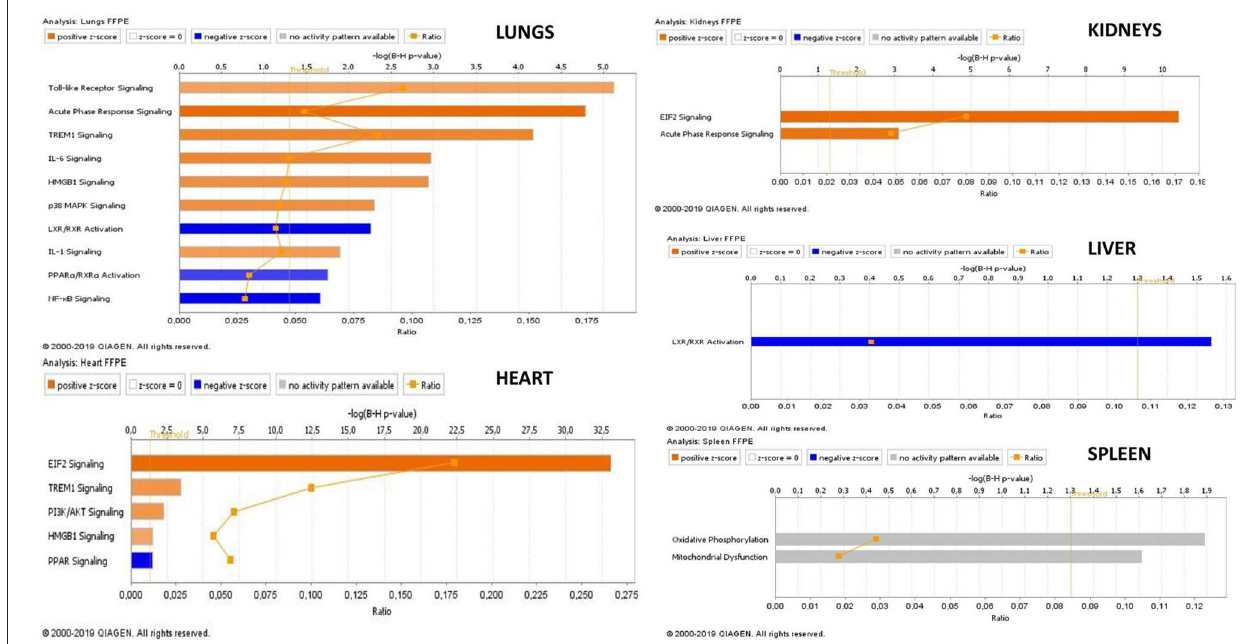
FIGURE 6 | Transcriptional profiles of canonical pathways in FFPE tissue samples from meningococcal septic shock patients. The figure displays the top canonical pathways enriched in each organ. The mean values of N. meningitidis DNA/ µ g human DNA was in lungs: 2.5 × 10 8 , heart 5.4 × 10 7 , kidneys 4.6 × 10 6 liver 8.3 × 10 7 , and spleen 9.4 × 10 4 . A ≪ core analysis ≫ was performed separately for each organ. Significantly enriched canonical pathways were identified with a right-tailed Fisher’s Exact Test ( p < 0.05, after correction for multiple testing using the Benjamini-Hochberg method). Ratio denotes the number of significantly expressed genes compared with the total number of genes associated with the canonical pathway. The Z-score = | ± 1| indicates predicted activation state of canonical pathway. Blue color or lighter shades of blue indicate a negative Z-score and down-regulation of the pathway, and orange or lighter shades of orange indicate a positive Z-score and up-regulation of the pathway. Gray color indicates no activity pattern available. Z-score value > | ± 1| are